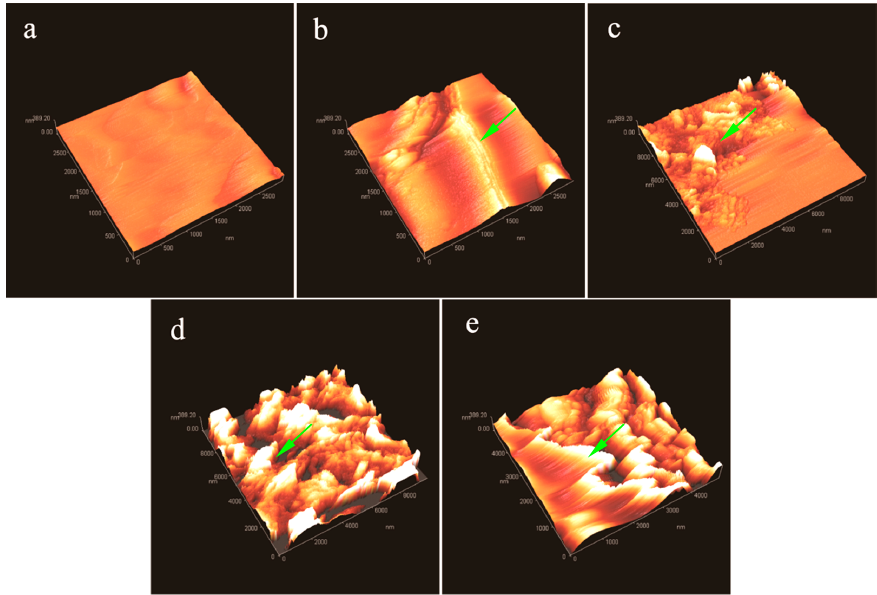
Figure 6. Transmission electron microscopy (TEM) morphologies of the microPCMs sample (MG-2), ( a ) the microPCMs particles on a copper screen; ( b ) a hybrid shell surface with graphene; and ( c ) typical graphene extending out of the shell surface (100 nm).